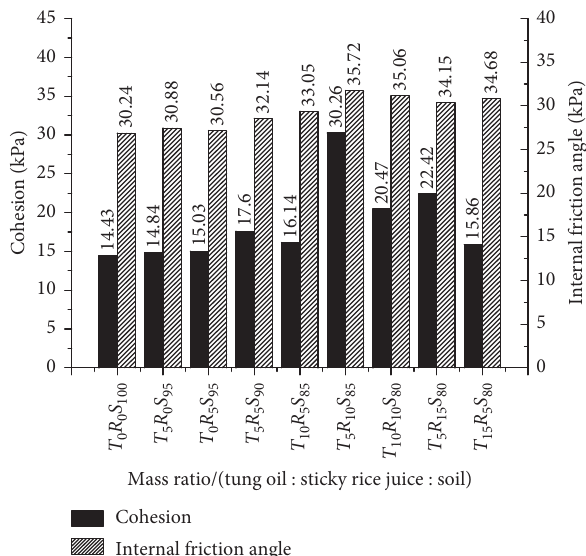
Figure 6: Steps in the north of the Tianluoshan site.